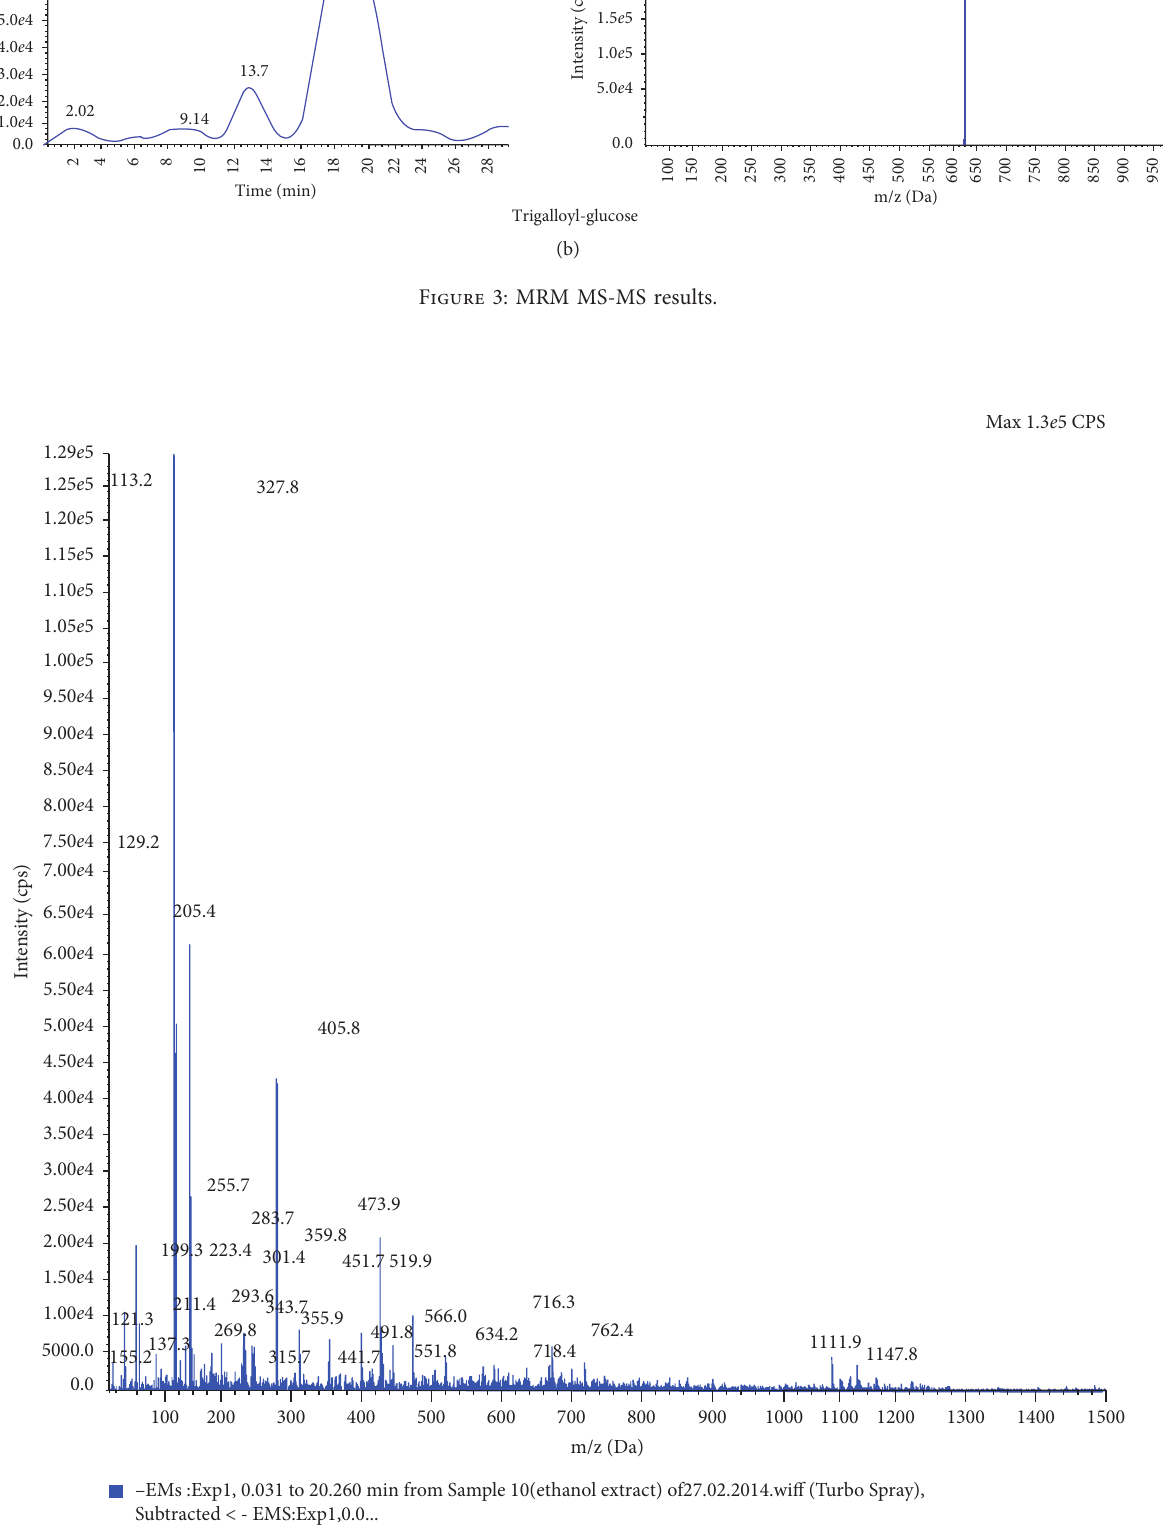
Figure 4: MS-MS scan